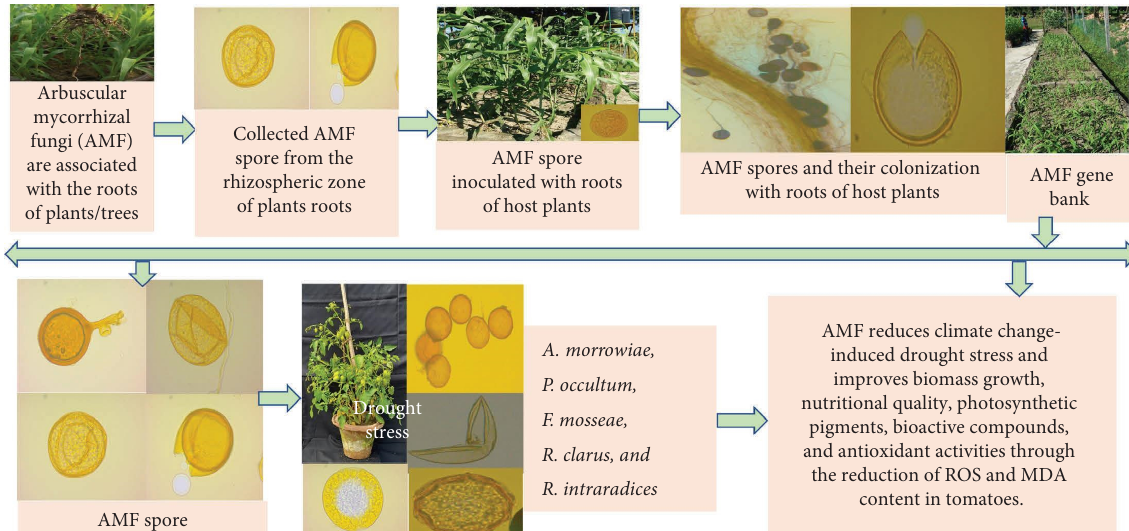
Figure 4: Arbuscular mycorrhizal fungi increase biomass growth and antioxidant activity and reduce climate change-induced drought stress in tomato